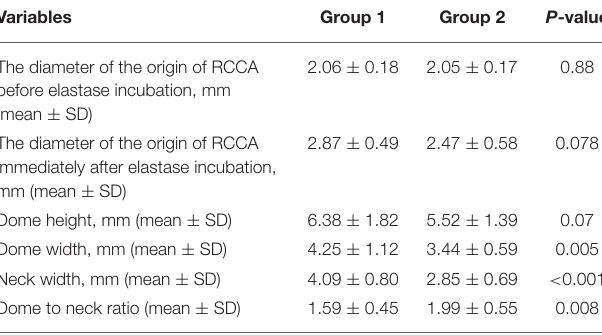
TABLE 1 | The diameter of the origin of the right common carotid artery (RCCA) before and immediately after elastase incubation and aneurysm sizes in groups 1 and 2.